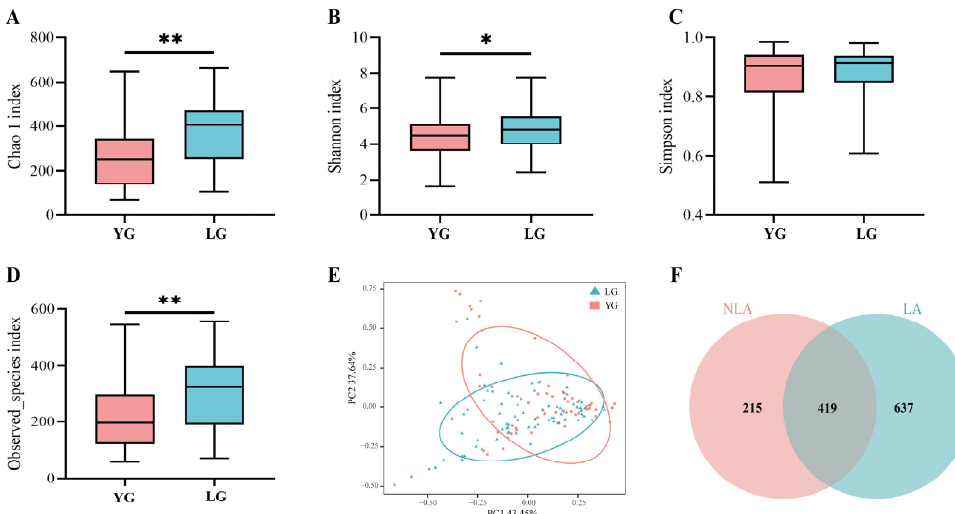
Figure 1. Characteristics of gut microbiota in Changshou District, Guangxi. ( A – D ) Comparison of α -diversity of intestinal microflora based on Chao1, Simpson, Shannon, and observed species index between LG and YG groups in Guangxi longevity area over 90 years of age. * indicates p < 0.05, and ** indicates p < 0.01 (Wilcoxon rank-sum test). ( E ) indicates principal component PCA analysis between LG longevity and YG groups. ( F ) OTU Venn diagram between longevity area (LA) and non-longevity area (NLA). ( F ) Ensemble plot showing the number of OTUs for each age group in the longevity area.